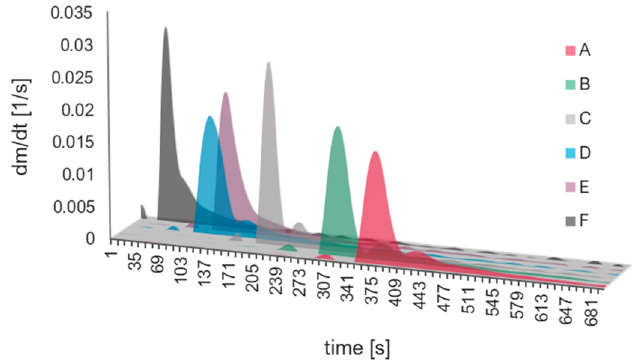
Figure 10. Dependence of dm/dt on time of reaction for syntheses A–F.